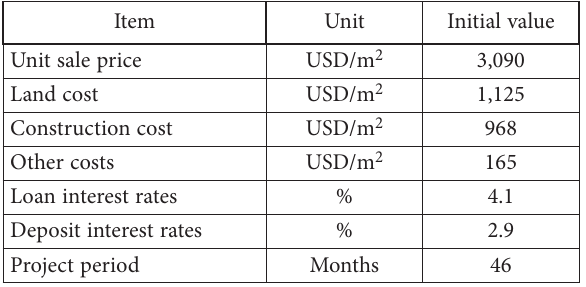
Table 2. Initial values of risk factors